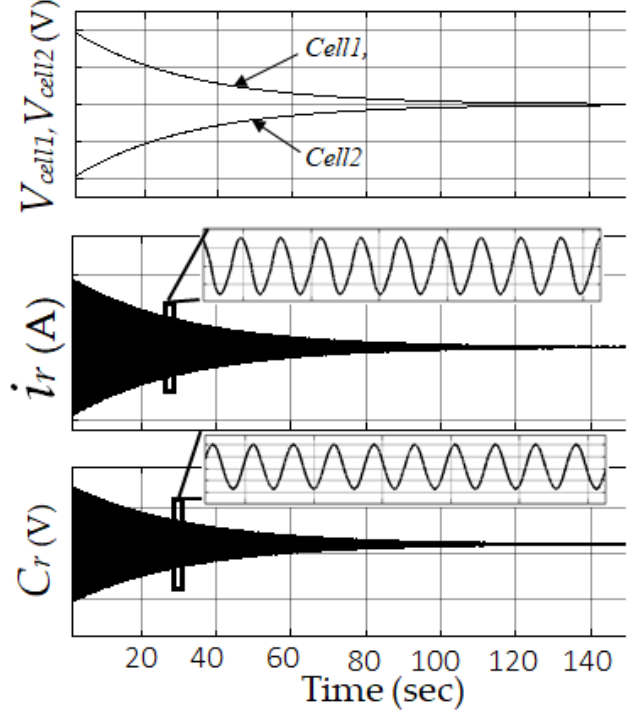
Figure 8. Simulation result of the voltage balancing system.